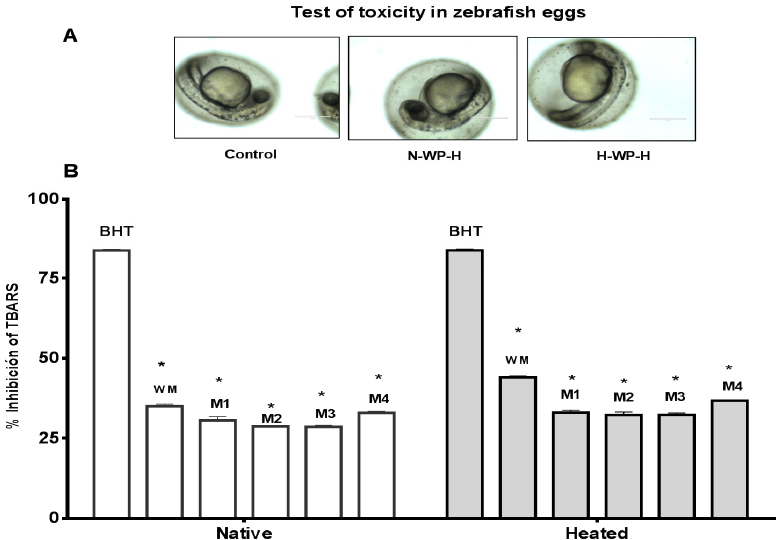
Figure 5. ( A ) Antioxidant activity of whey protein hydrolysate at concentration of 0.4 mg/mL. TBARS in zebrafish larvae model BHT (positive control). Native = native casein hydrolysate, Heated = heated casein hydrolysate. WM = whole milk, M1 = milk 1, M2 = milk 2, M3 = milk 3, M4 = milk 4. Results represent the average of two determinations ± SD ( n = 30). * Denotes p < 0.05 as compared to positive control (two ‐ way ANOVA/Tukey). ( B ) Test of toxicity in zebrafish eggs of N ‐ WP ‐ H (native whey protein hydrolysate) and H ‐ WP ‐ H (heated whey protein hydrolysate).